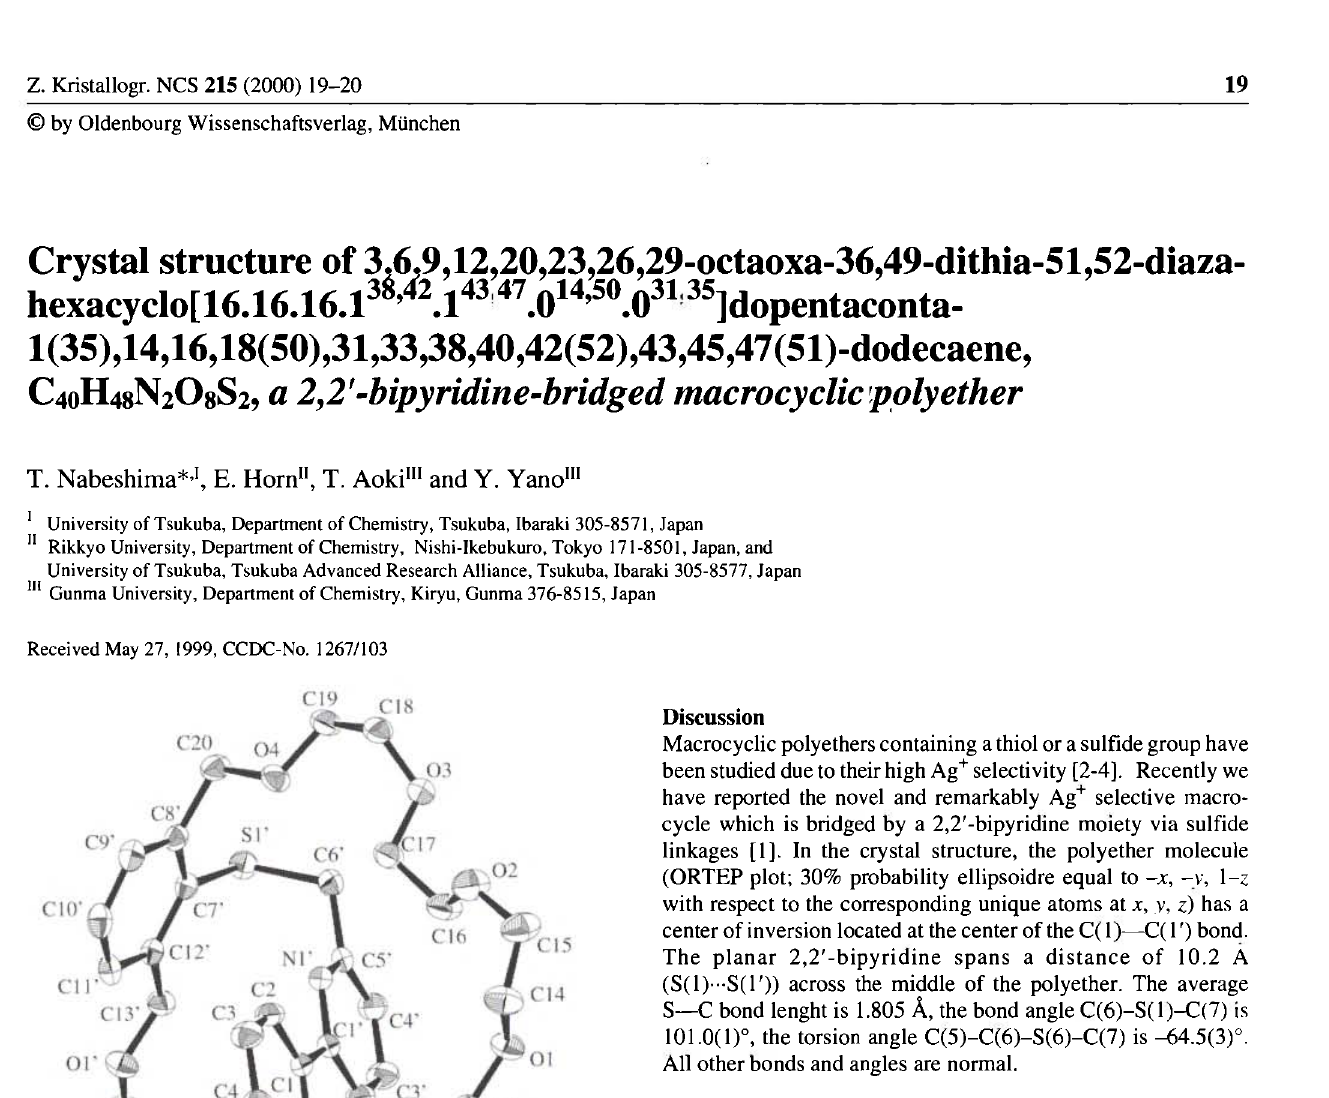
Table 1. Data collection and handling.